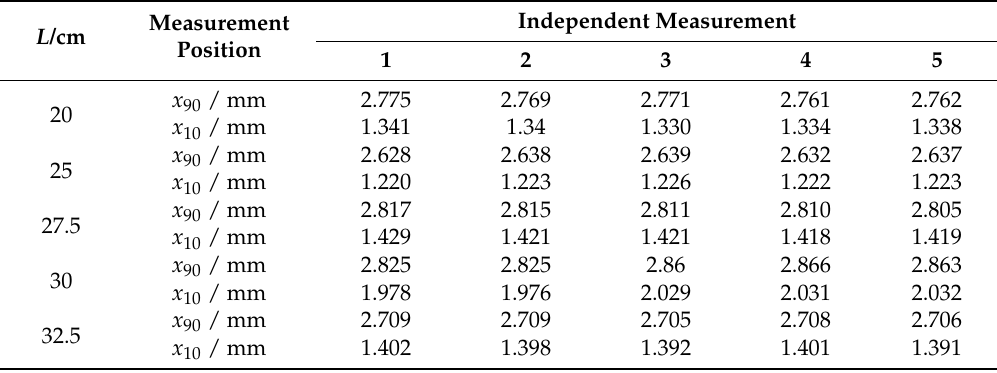
Table 1. Value of A corresponding to different F . L = the distance between the measurement location and laser outlet. A and F are shown in Equation 3 in Materials and Methods.